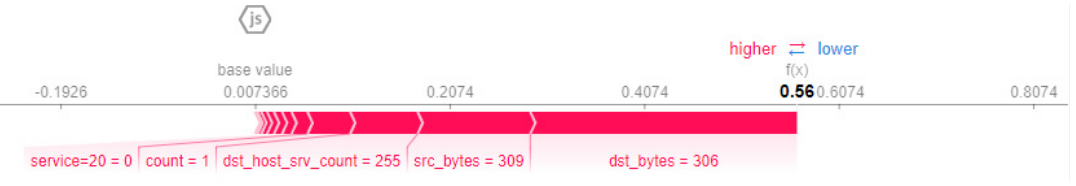
Figure 9. Interpretation of the adversarial robust model on Prob